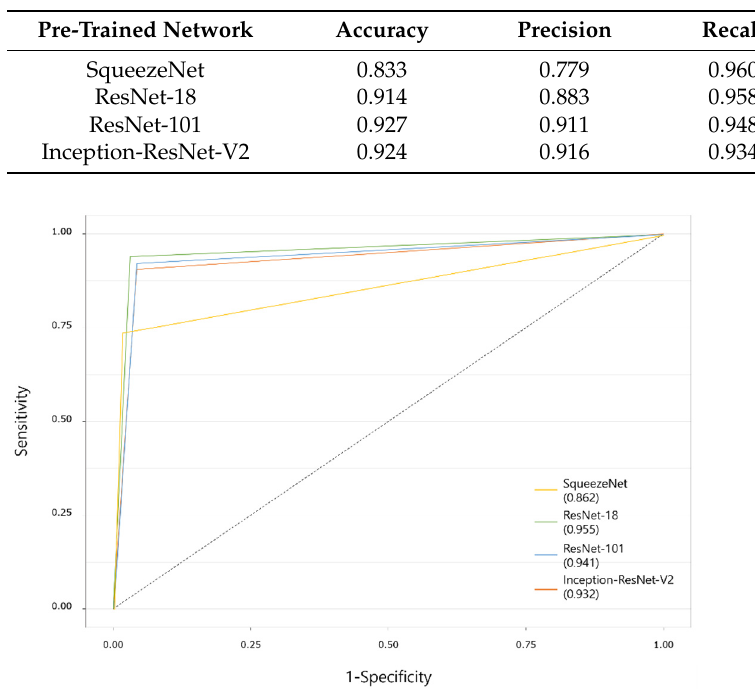
Figure 3. Receiver operating characteristic curves of deep-learning models on dataset 1. Numbers in parentheses show the area under the curve values.